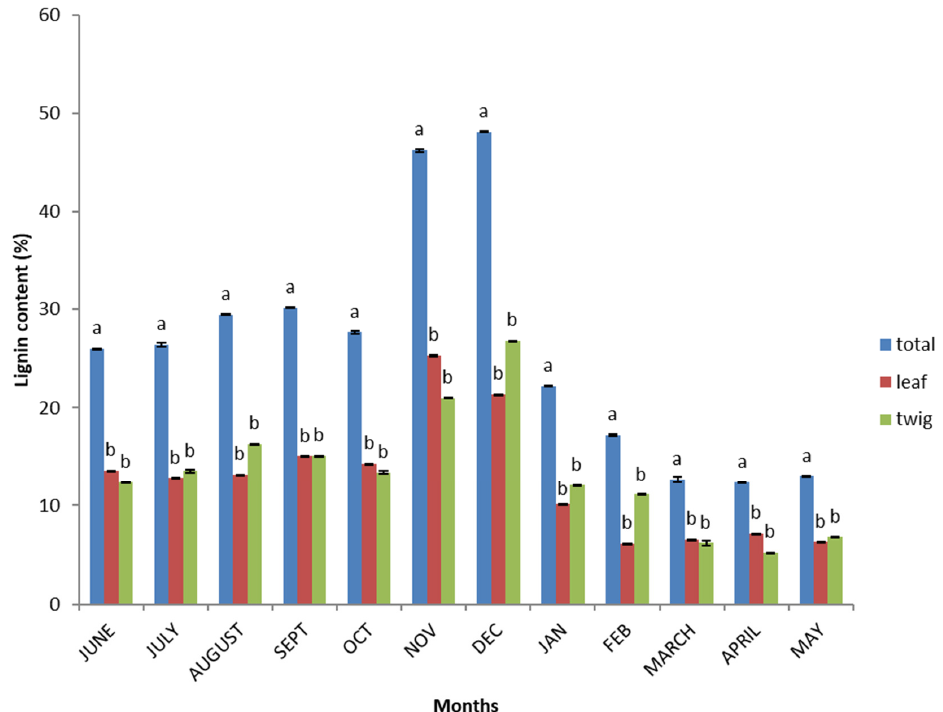
Figure 1a. Monthly lignin content in the litter fall of bamboo stands in a regenerating forest, Ile-Ife *Vertical bars of the same alphabet in a month are not significantly (p > 0.05) different using Duncan Multiple Range Test